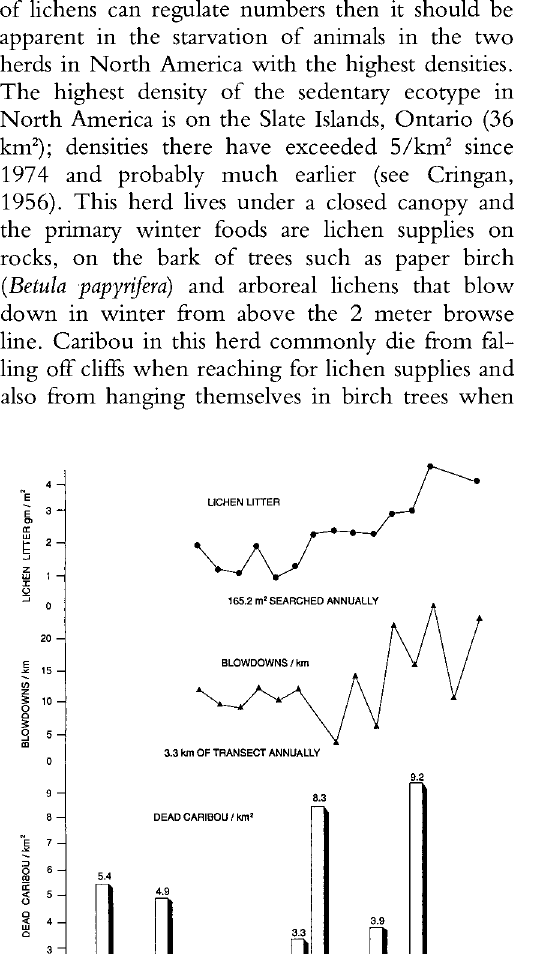
Fig. 3. The caribou that died/km 2 found on the Slate Islands by strip censuses in May-June (below) was not correlated with the number of trees that blew down with lichen loads counted the following spring (middle) nor with the lichen litter found in exclosures in the spring. More lichens are blowing down annually as the forests get